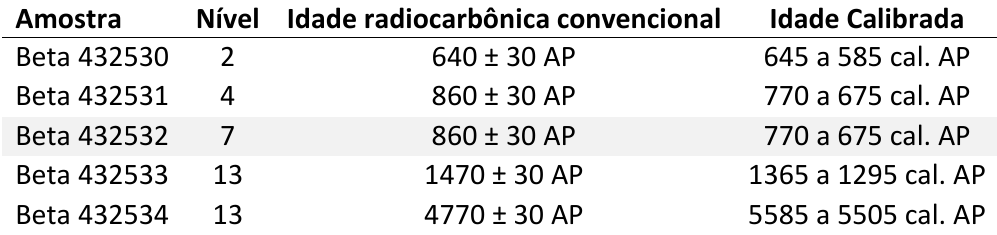
Table 2. C 14 dated samples from the Abrigo de Itapeva